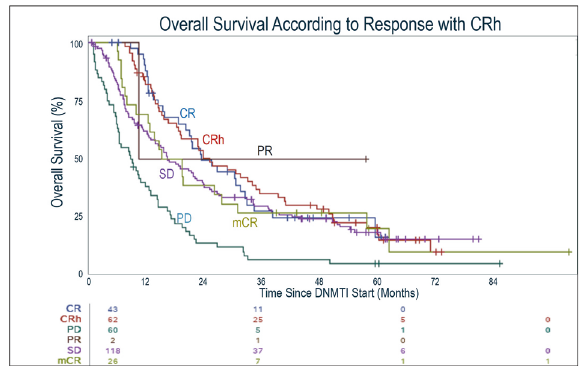
Fig. 3 Overall survival from the time of therapy initial until death or last known alive, among patients treated with DNMTI therapy. Survival is shown according to the best overall response on DNMTI therapy (IWG 2006 criteria) but including patients who met CRh and reclassifying them from patients who met mCR or SD. Median OS was similar between CR (23.3mo) and CRh (25mo). This was longer than patients whose best response remained classi fi ed as mCR (17.2mo), SD (16.3mo), and PD (8.7mo) ( p <